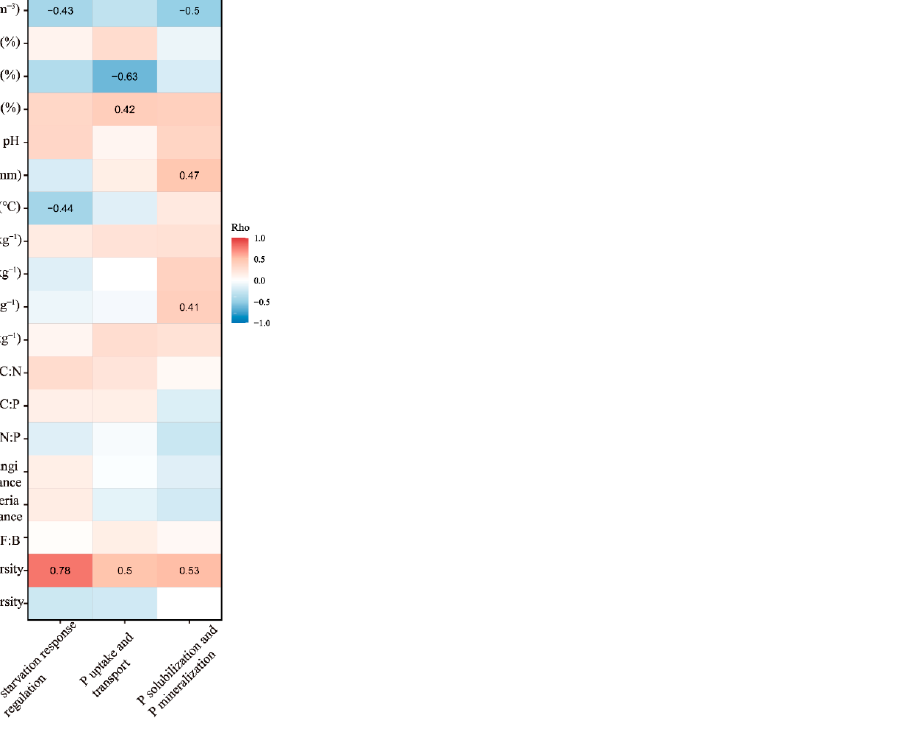
Figure 3. Relationships among factors and the P functional genes at eight forest biomes along the latitude.